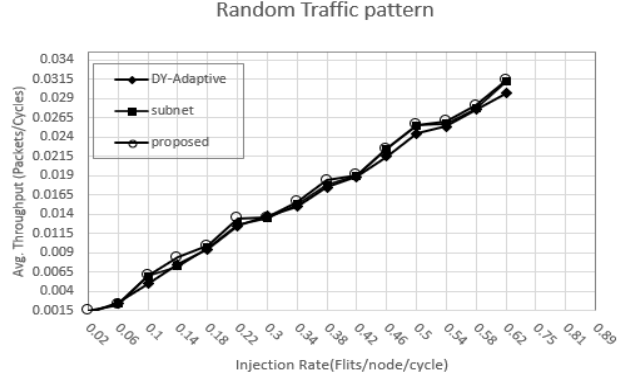
Fig. 13 Average throughput evaluation under synthetic uniform random traffic pattern